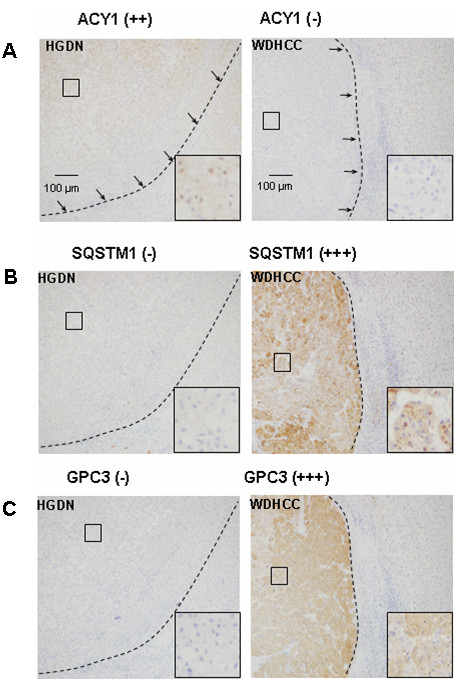
Expression patterns of three biomarkers in large sections of HGDN and WDHCC. Expression patterns of ACY1 (A), SQSTM1 (B), and GPC3 (C) examined by immunohistochemistry (×200) in HGDN and WDHCC validation set. Dotted line indicates the boundary between the tumor (HGDN and WDHCC) and the non-tumor tissues. Insert shows high magnification image.